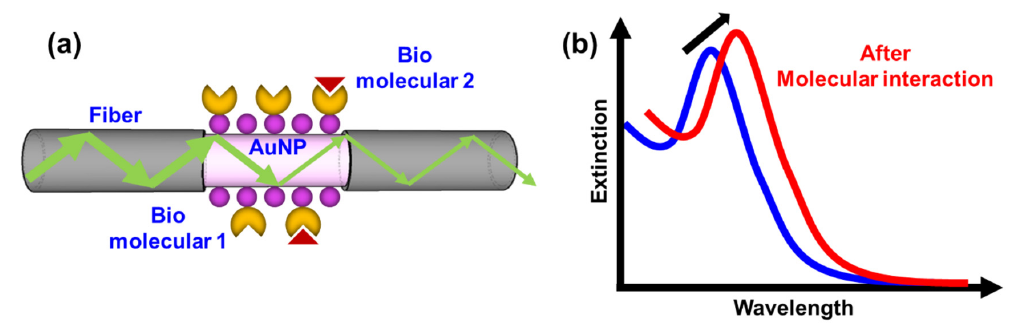
Figure 1. ( a ) Schematic diagram of the fiber-optic particle plasmon resonance (FOPPR) sensor; ( b ) Illustration of the FOPPR spectra with molecular interaction.